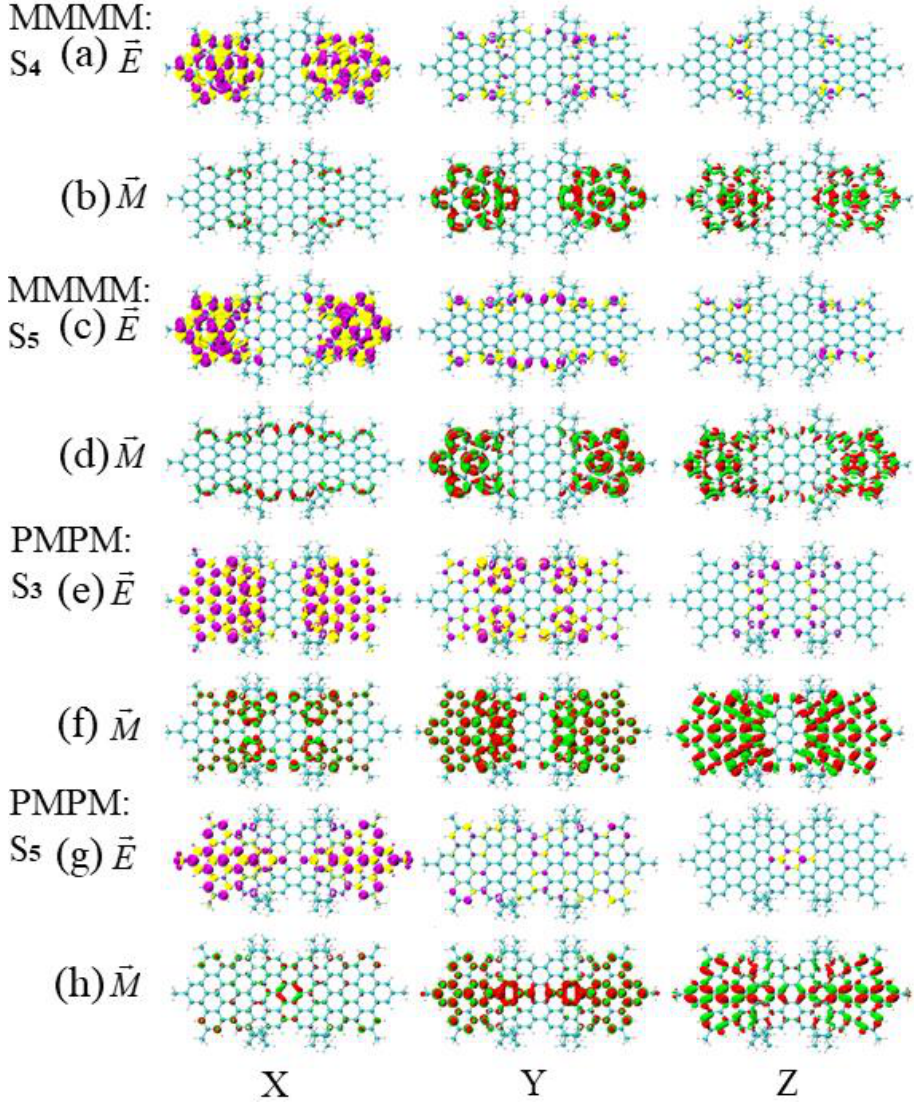
Figure 12. The TEDM and TMDM at similar wavelengths for asymmetric isomers (MMMM) and symmetric diastereomers (PMPM). ( a , b ) are distributed as the TEDM and TMDM in the x/y/z direction of S4 of MMMM near the wavelength of 408 nm; ( c , d ) are distributed as the TEDM and TMDM in the x/y/z direction of S5 of MMMM near the wavelength of 376 nm; ( e , f ) are distributed as the TEDM and TMDM in the x/y/z direction of PMPM near the wavelength of 407 nm; ( g , h ) are distributed as the TEDM and TMDM in the x/y/z direction of S5 of PPMM molecules near the wavelength of 376 nm. The letters E and M in the figure indicate the TEDM and TMDM of the molecule, respectively.